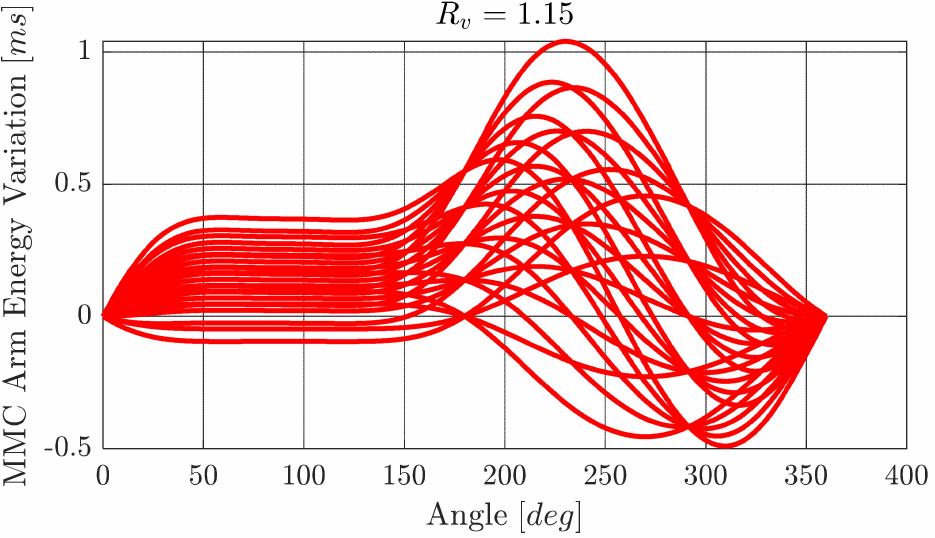
Figure 6. MMC arm energy variation over the period in 25 different PQ work